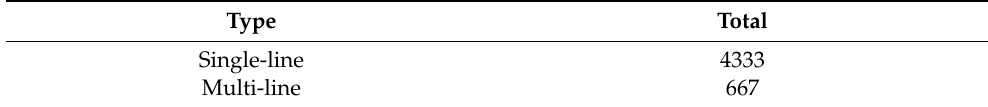
Table 6. Distribution of data by “type” column.